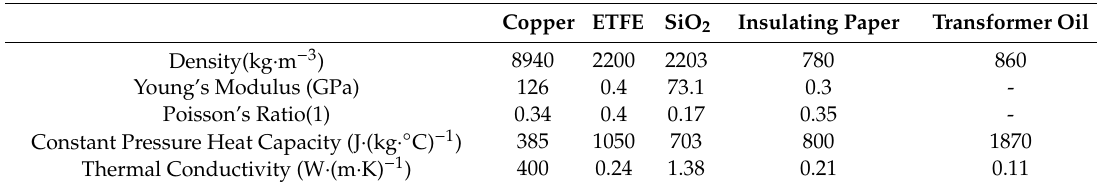
Table 1. Material Parameters for Simulation Model [13,26].